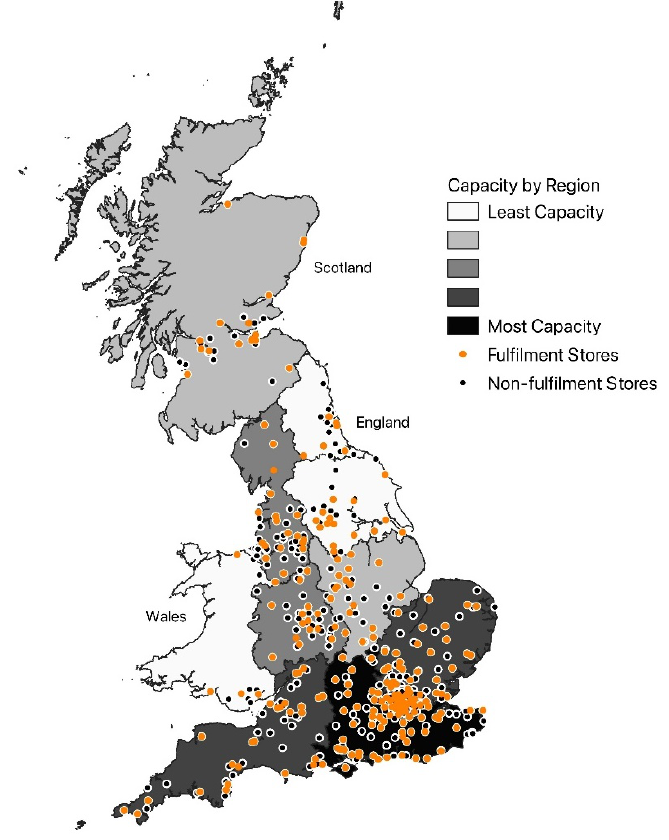
Figure 1. Sainsbury’s online groceries delivery capacity by region (2019), with fulfilment stores